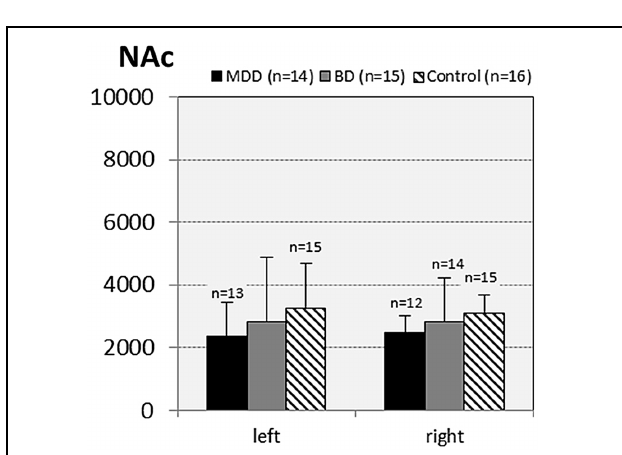
FIGURE 6 | Numerical densities of GS-expressing glial cells (ACs and OLs) in the NAc of subjects with MDD, BD, and controls. No significant alterations were found in this brain